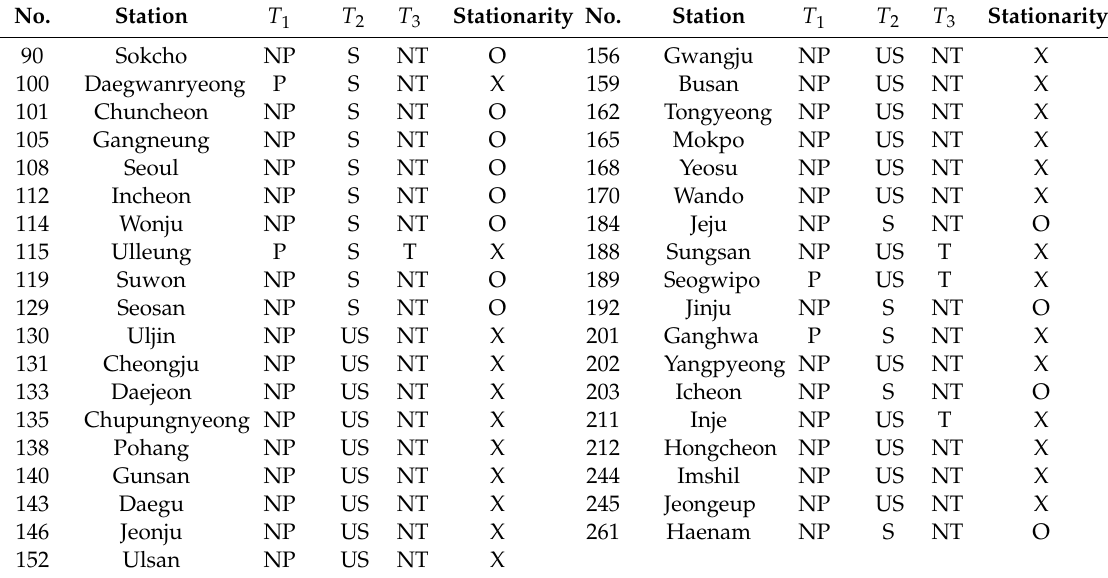
Table 5. Estimation of the stationarity of annual precipitation data.